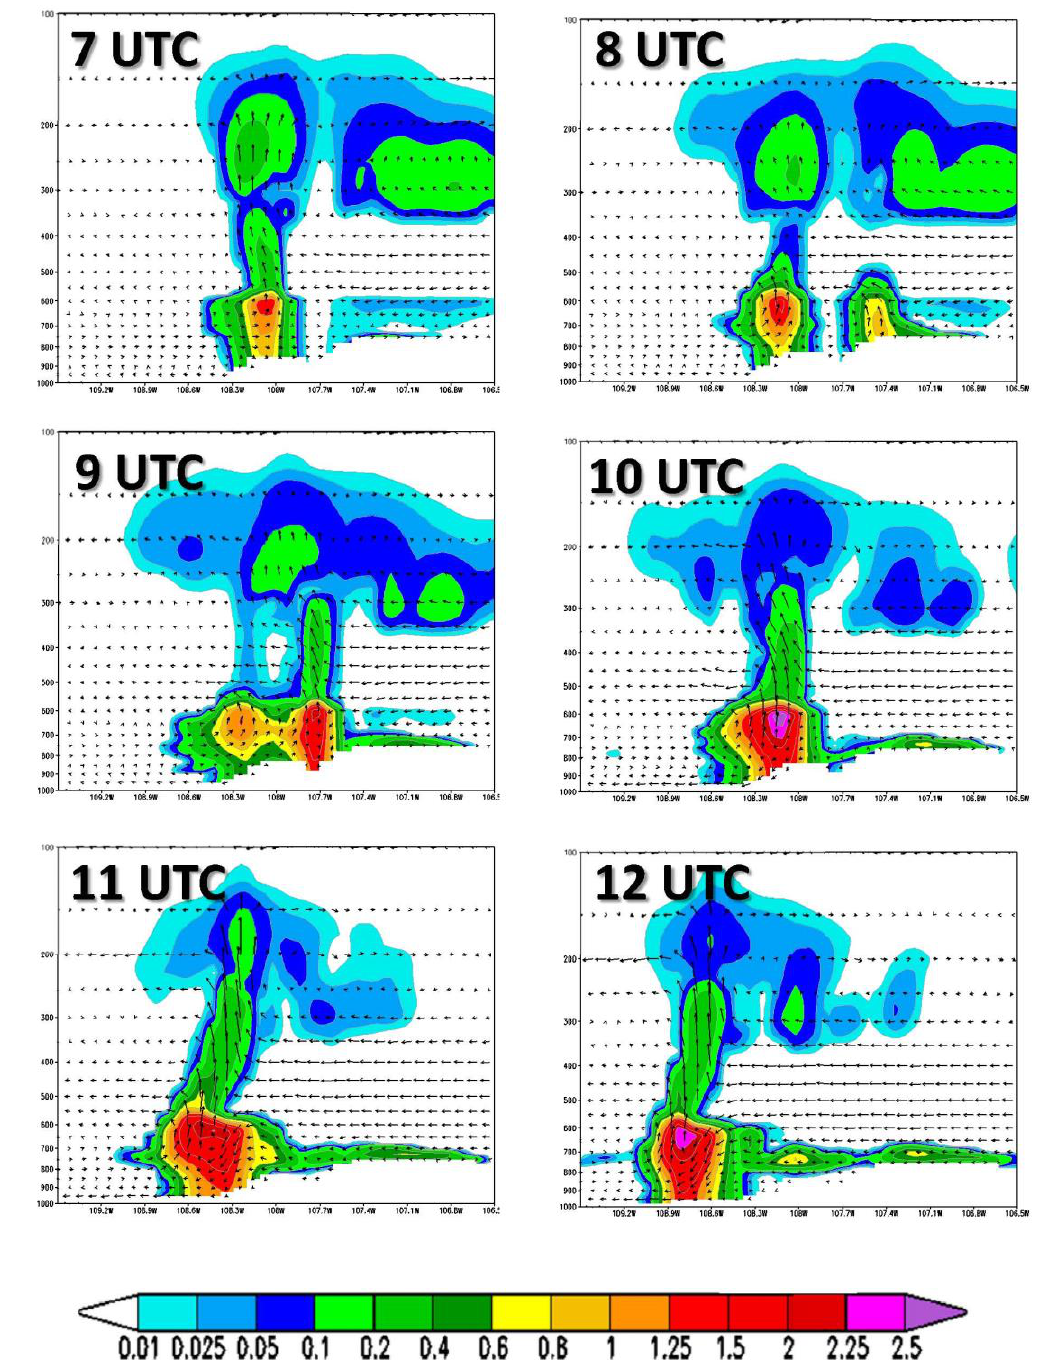
Figure 7. Cross-section of modified WRF model simulated total water condensation (kg kg −1 ) from 7 UTC to 12 UTC 14 July. Each panel indicates model output at the specified UTC time as labeled. Wind vectors are scaled such that the horizontal wind is ten times larger than the vertical wind in order to show updrafts and downdrafts. The vertical planes to construct the cross section are defined at latitude 26.8° N extending in the x -axis from 109.5° W to 106.5° W. The y -axis is log pressure scaling from 1000 mb at surface to 100 mb near the tropopause.